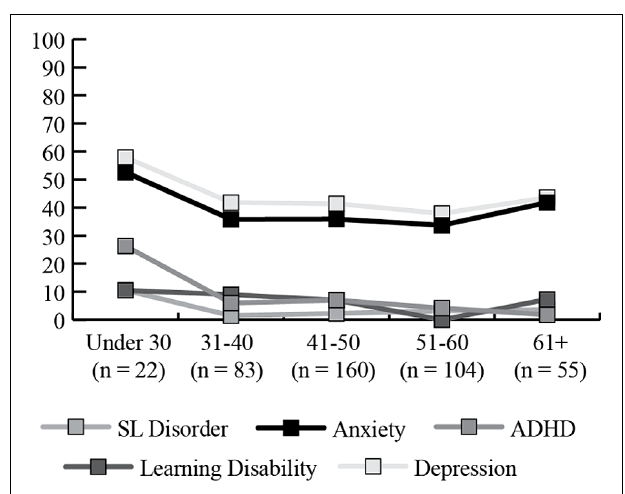
FIGURE 2 | Percentage of women endorsing co-occurring psychiatric or educational conditions, by age group.